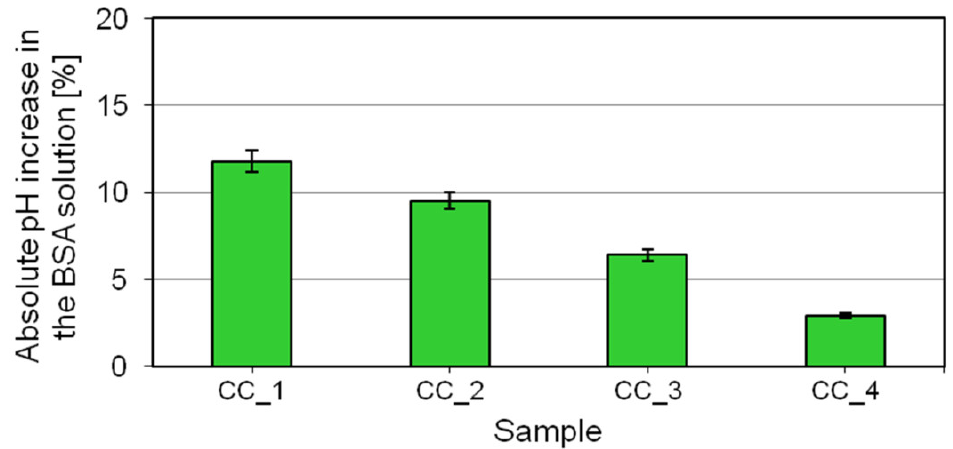
Figure 5. Changes in pH of the mixture of bovine serum albumin solutions and shower gels containing the digestate extract.